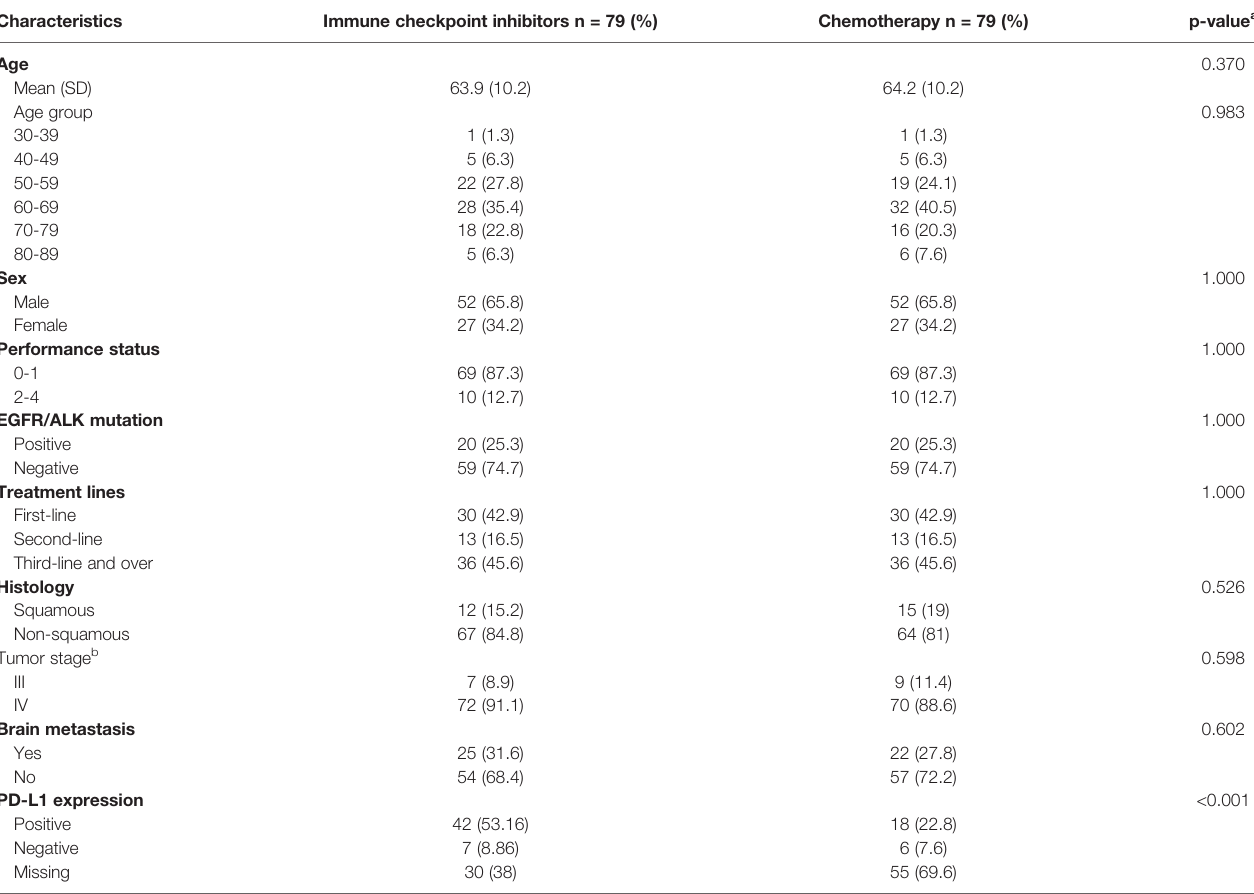
TABLE 1 | Demographic characteristics of study population after matching.